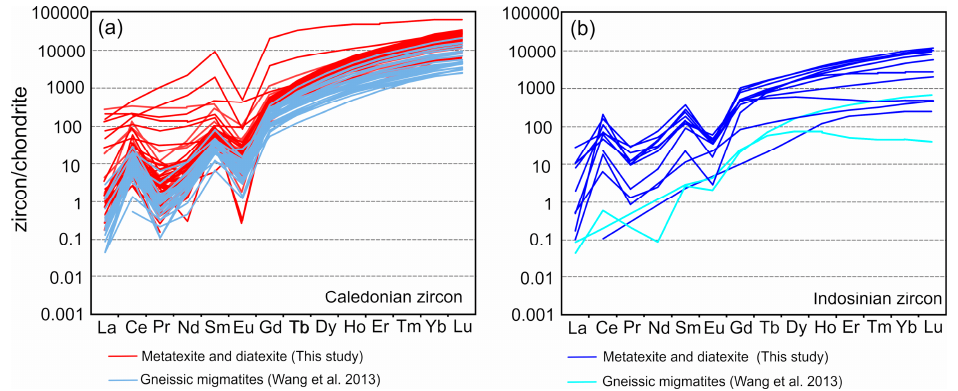
Figure 10. Comparison of chondrite-normalized REE patterns of ( a ) Caledonian zircon and ( b ) Indosinian zircon from this study and from [30]. Chondrite values are from [58].